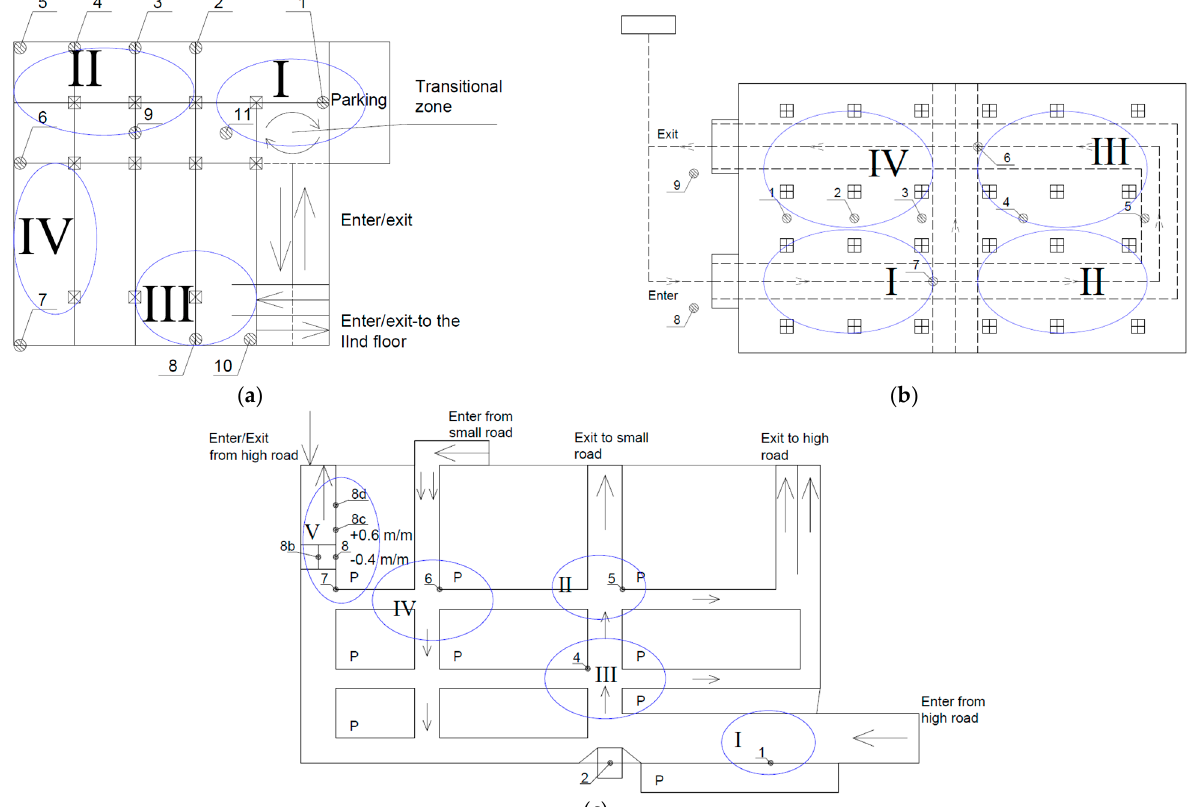
Figure 3. A principal view of the closed area and the air pollution research site ( a – c ). Zone A: area 700 m 2 , volume 2800 m 3 . The territory is installed on raised foundations,